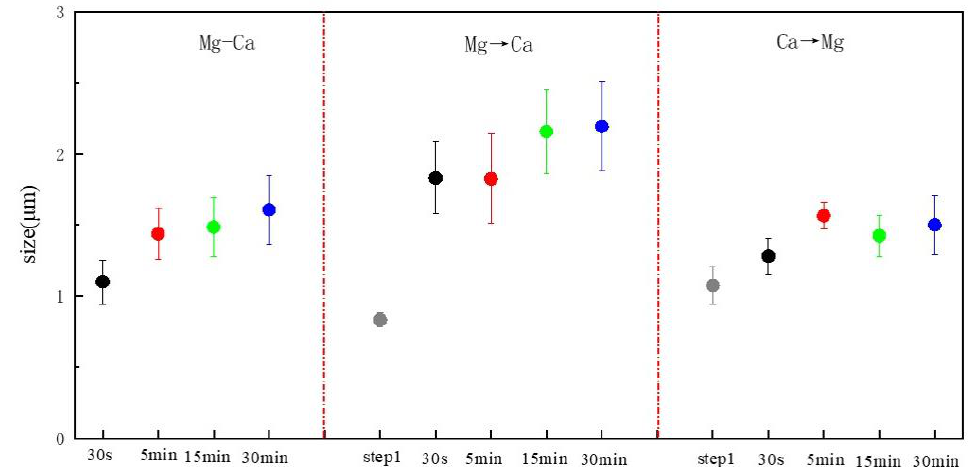
Figure 10. Size variation of inclusions in the three experiments.